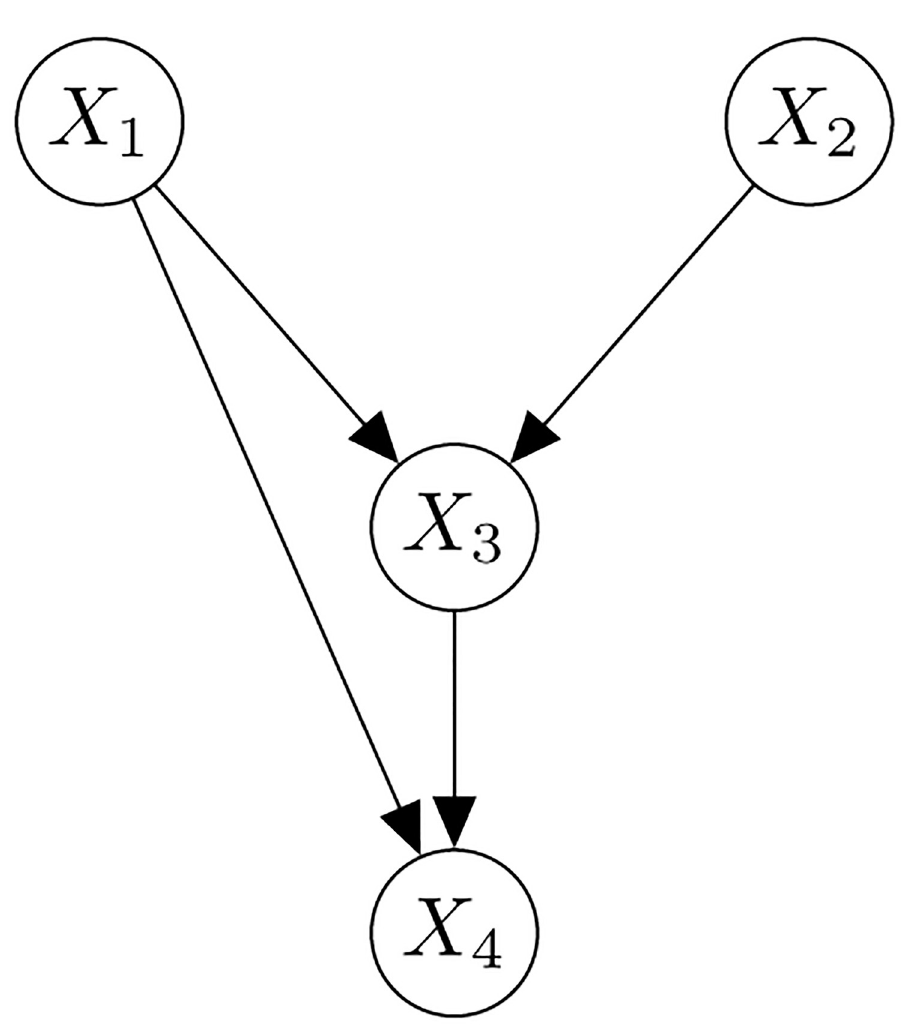
Fig 2. An example of a Bayesian network of four variables, X 1 , X 2 , X 3 , and X 4 . Network density. The network density measures the connectedness of a network. Intui- tively, the more connections or more edges a BN has, the higher the network density will be. The network density at time t is defined as 2 e t Þ ¼ ; ð 3 Þ ND ð G t ð v (cid:0) 1 Þ v t t where v and e are, respectively, the number of nodes and the number of edges of the network t t . It is the ratio of the number of edges in G to the maximum possible number of edges, G (cid:0) � t t v t ¼ v ð v (cid:0) 1 Þ = 2 , implying that ND ð G Þ lies between 0 and 1. As edges in a BN represent t t t 2 directed links among variables, ND ð G Þ , which gives the proportion of edges in the BN, quan- t tifies the complexity of the BN to represent hidden conditional dependence structures among variables. In the structural learning of Bayesian networks, we often impose a restriction on the maximum number of parents for each node for the sake of computational efficiency. Under (cid:0) � this restriction, the maximum possible number of edges is much smaller than v t . Suppose 2